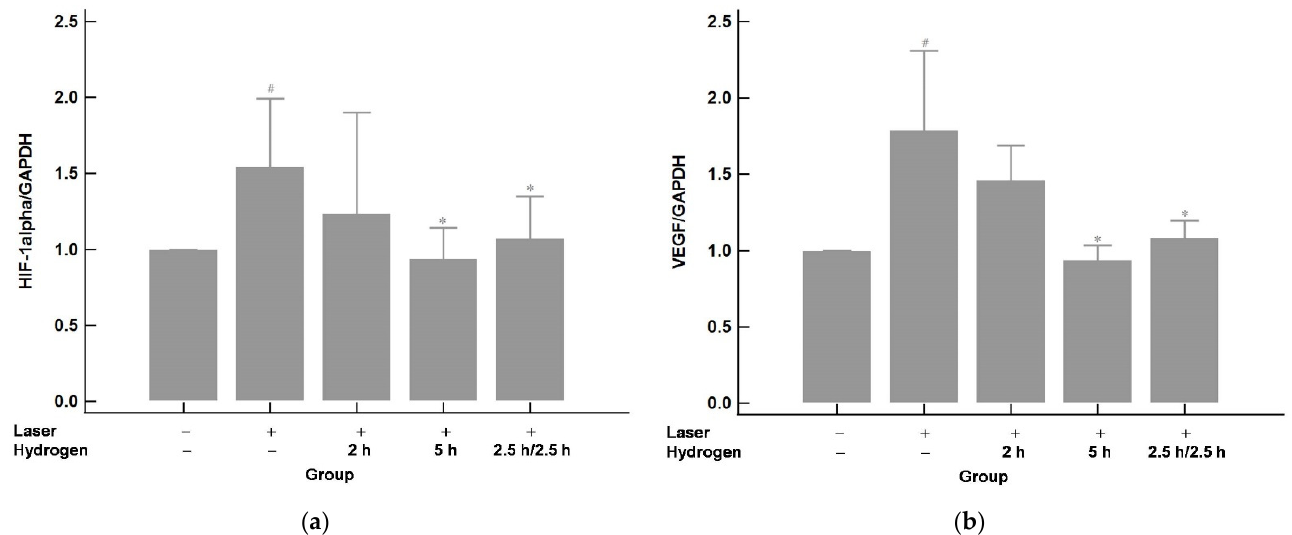
Figure 5. The mRNA expression of HIF-1 α ( a ) and VEGF ( b ). The expression of HIF-1 α and VEGF increased after laser photocoagulation compared with those of the control (no laser or hydrogen inhalation). The elevated HIF-1 α and VEGF expression was downregulated by hydrogen inhalation. The effect was similar between the 2.5 h/2.5 h and 5 h groups and showed to be less effective in the 2 h group. # p < 0.05 compared with the control (laser − /hydrogen − ) group; * p < 0.05 compared with the laser+ / hydrogen − group.